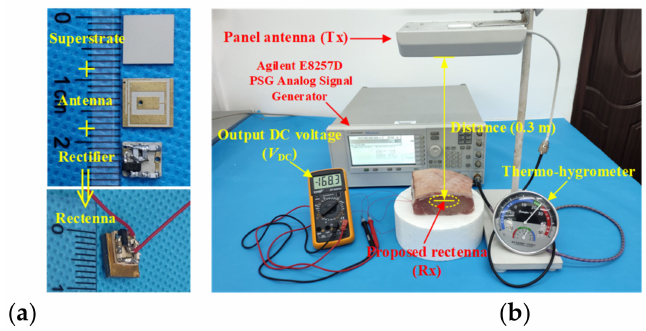
Figure 18. Photograph of measurement setup for wireless power transfer: ( a ) Fabricated implantable rectenna and ( b ) measurement setup.